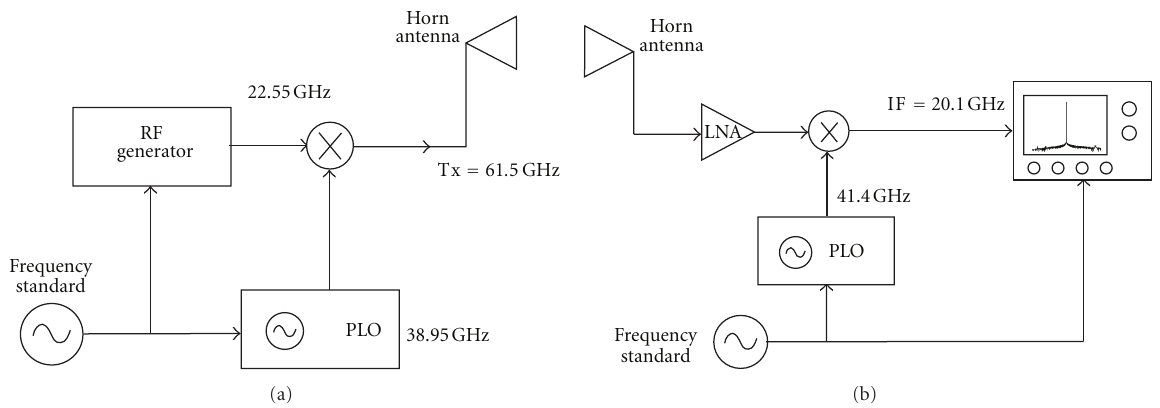
Figure 7: Functional diagram of narrowband sounder used at 61.5 GHz experiments: (a) transmitter and (b) receiver.